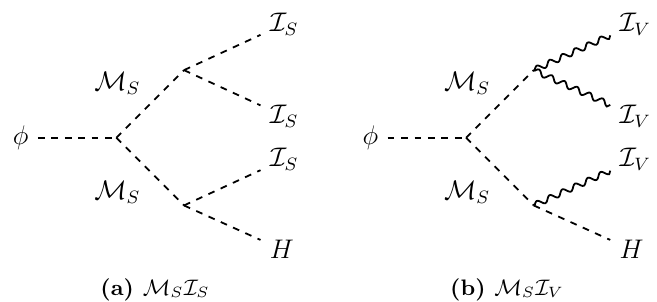
Figure 13. Mono-Higgs ( H ) + E miss